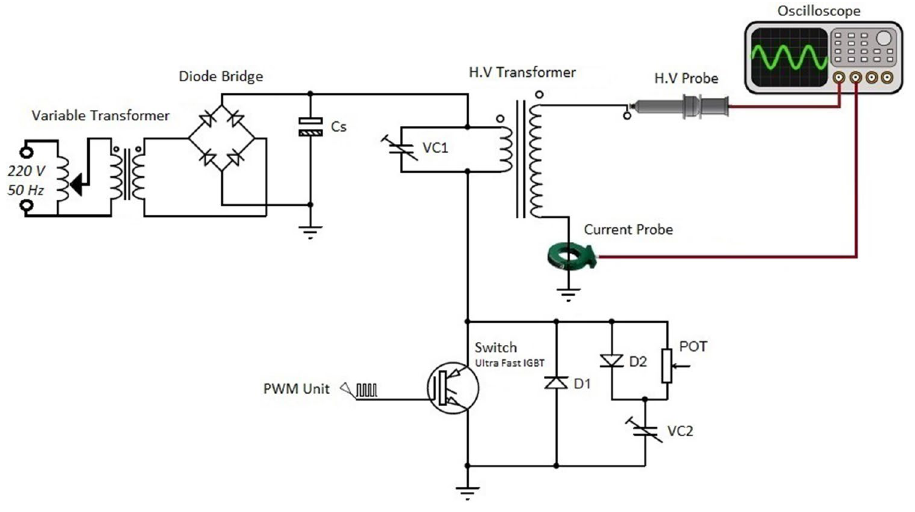
Figure 19. Pulsed high voltage power supply